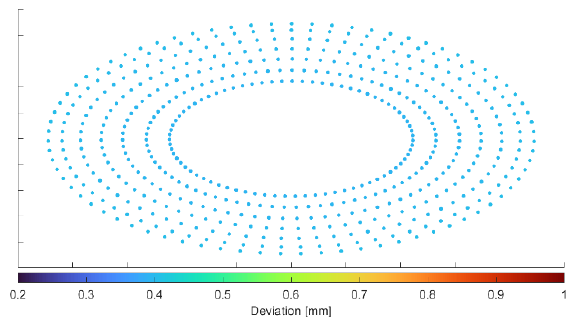
Figure 7 . Accuracy of the different measurement positions after the forward intersection.